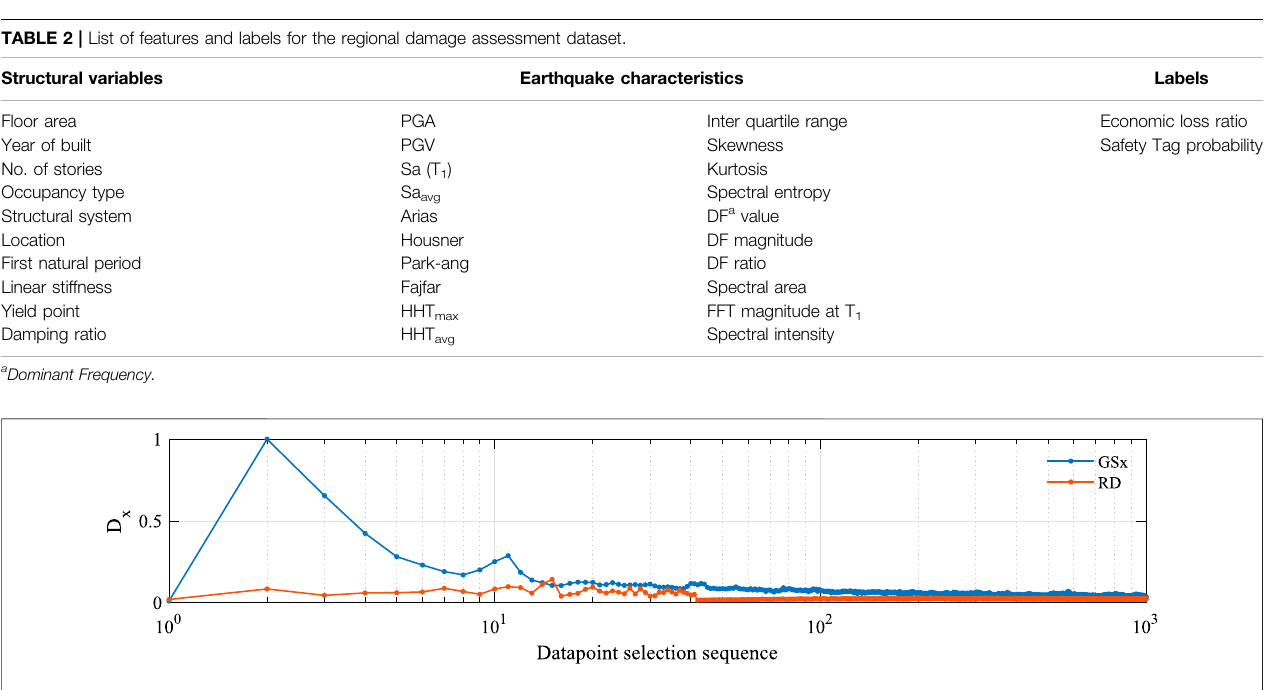
FIGURE 5 | Sequence of the selected datapoints by the GSx and RD methods based on their distance from the center of the input domain.